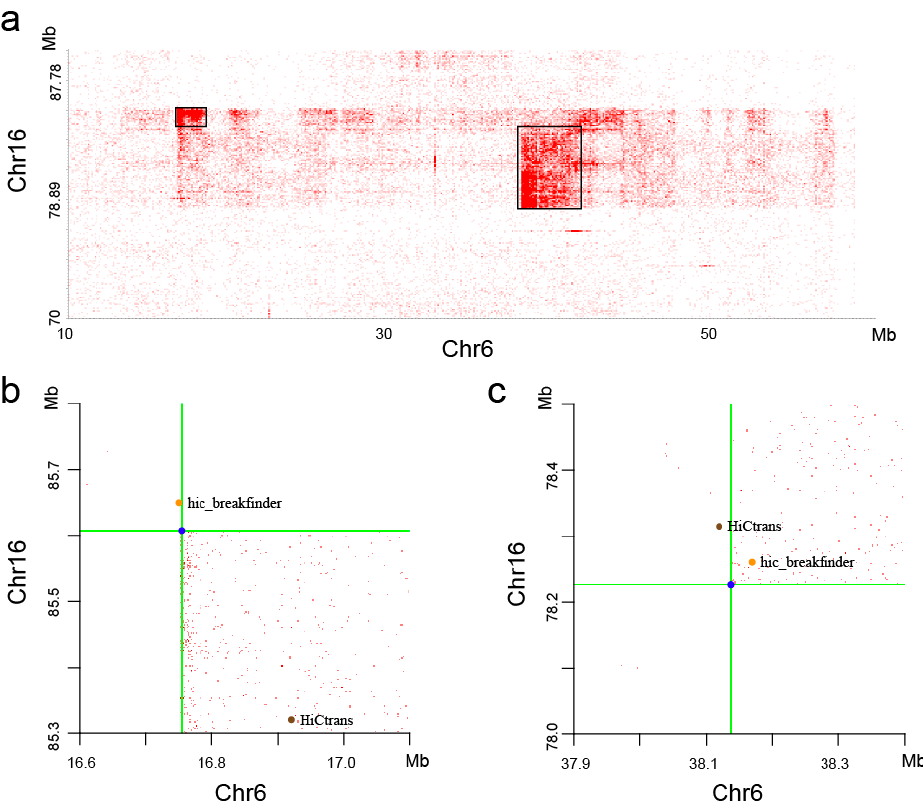
Figure 9. Translocation regions between chr6 and chr16. ( a ) The translocation region obtained from the heatmaps generated by the DLO Hi-C tool, with the translocations marked as black rectangles. ( b and c ) The translocations found by hic_breakfinder and HiCtrans.